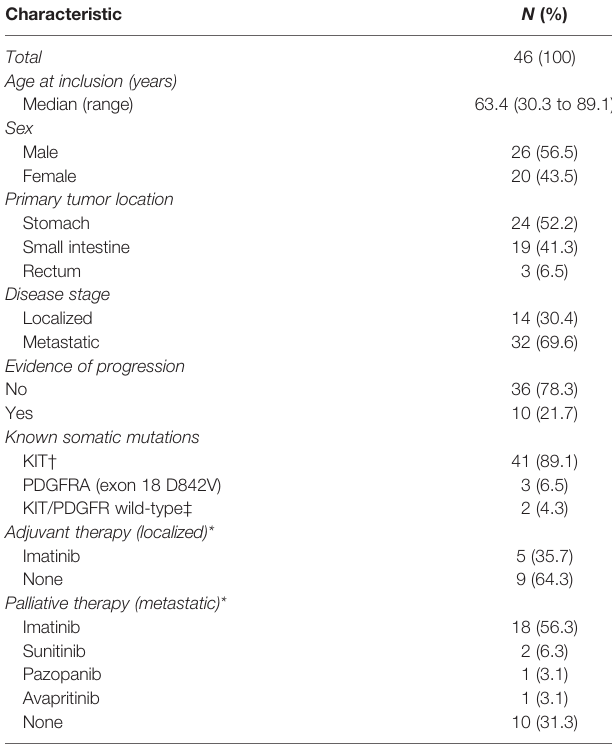
TABLE 1 | Characteristics of GIST patients at